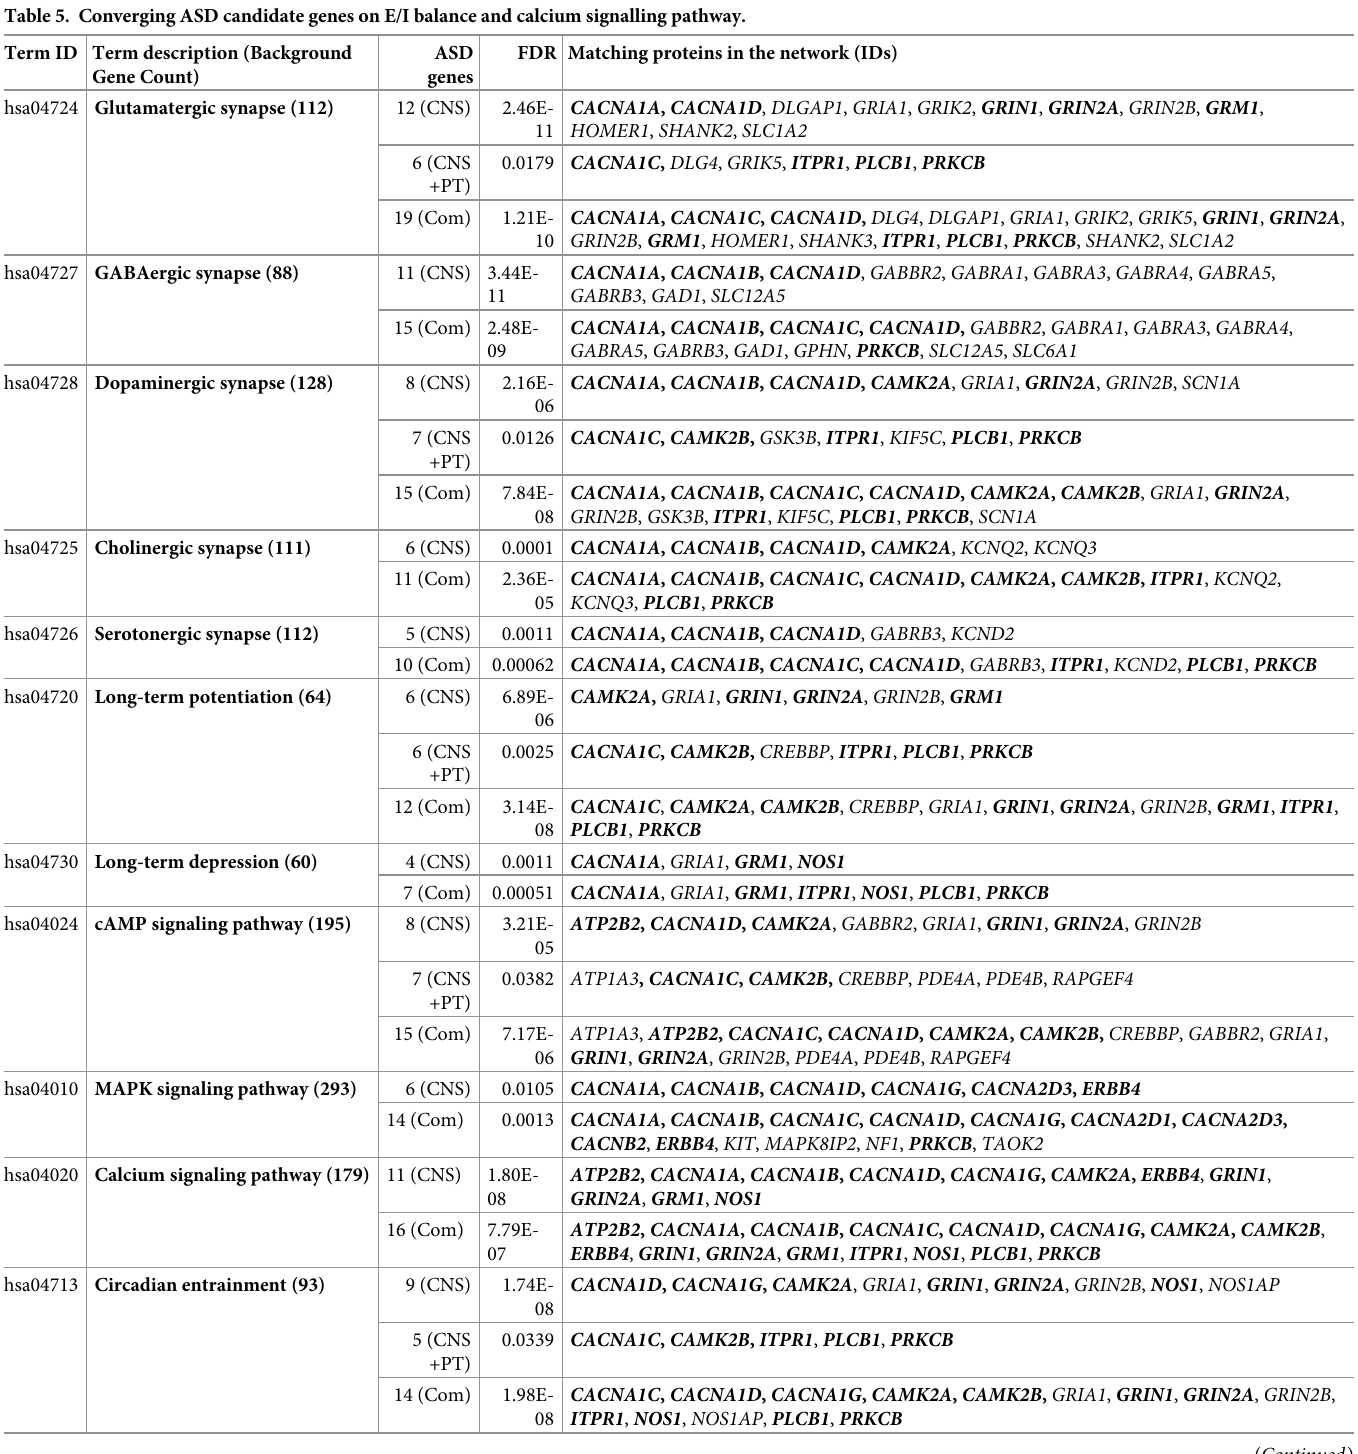
Table 5. Converging ASD candidate genes on E/I balance and calcium signalling